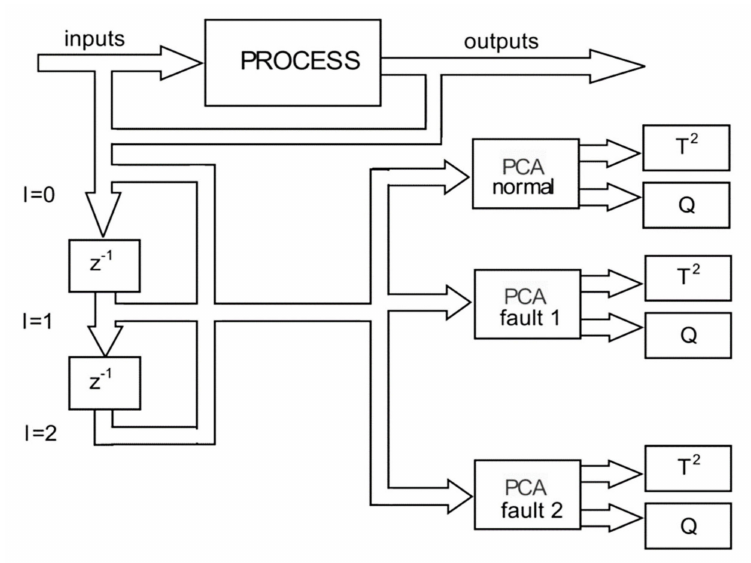
Figure 15. The software architecture for the detection of defects and